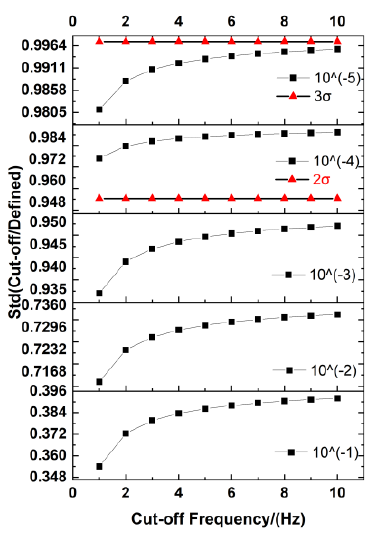
( b ) Figure 4. ( a ) One-dimensional spatial simulation point distribution diagram; ( b ) Two-dimensional spatial simulation point distribution diagram. 3.3. Compensation Coefficient 𝛽 Correction Method According to Section 3.2, the time history simulation of the fluctuating wind speed in a turbulent wind field is performed under the condition that the simulated frequency range is determined as [𝐹 (cid:2923)(cid:2911)(cid:2934), 𝐹 (cid:3040)(cid:3036)(cid:3041) ] = [10 (cid:2879)(cid:2872) , 5] . The main parameters are shown in Table 5, and the distribution of the standard deviation error and compensation coefficient at each simulated height in space is obtained, as shown in the Figure 5. The longitudinal Kaimal spectrum is modified by considering the compensation co- efficient 𝛽 :